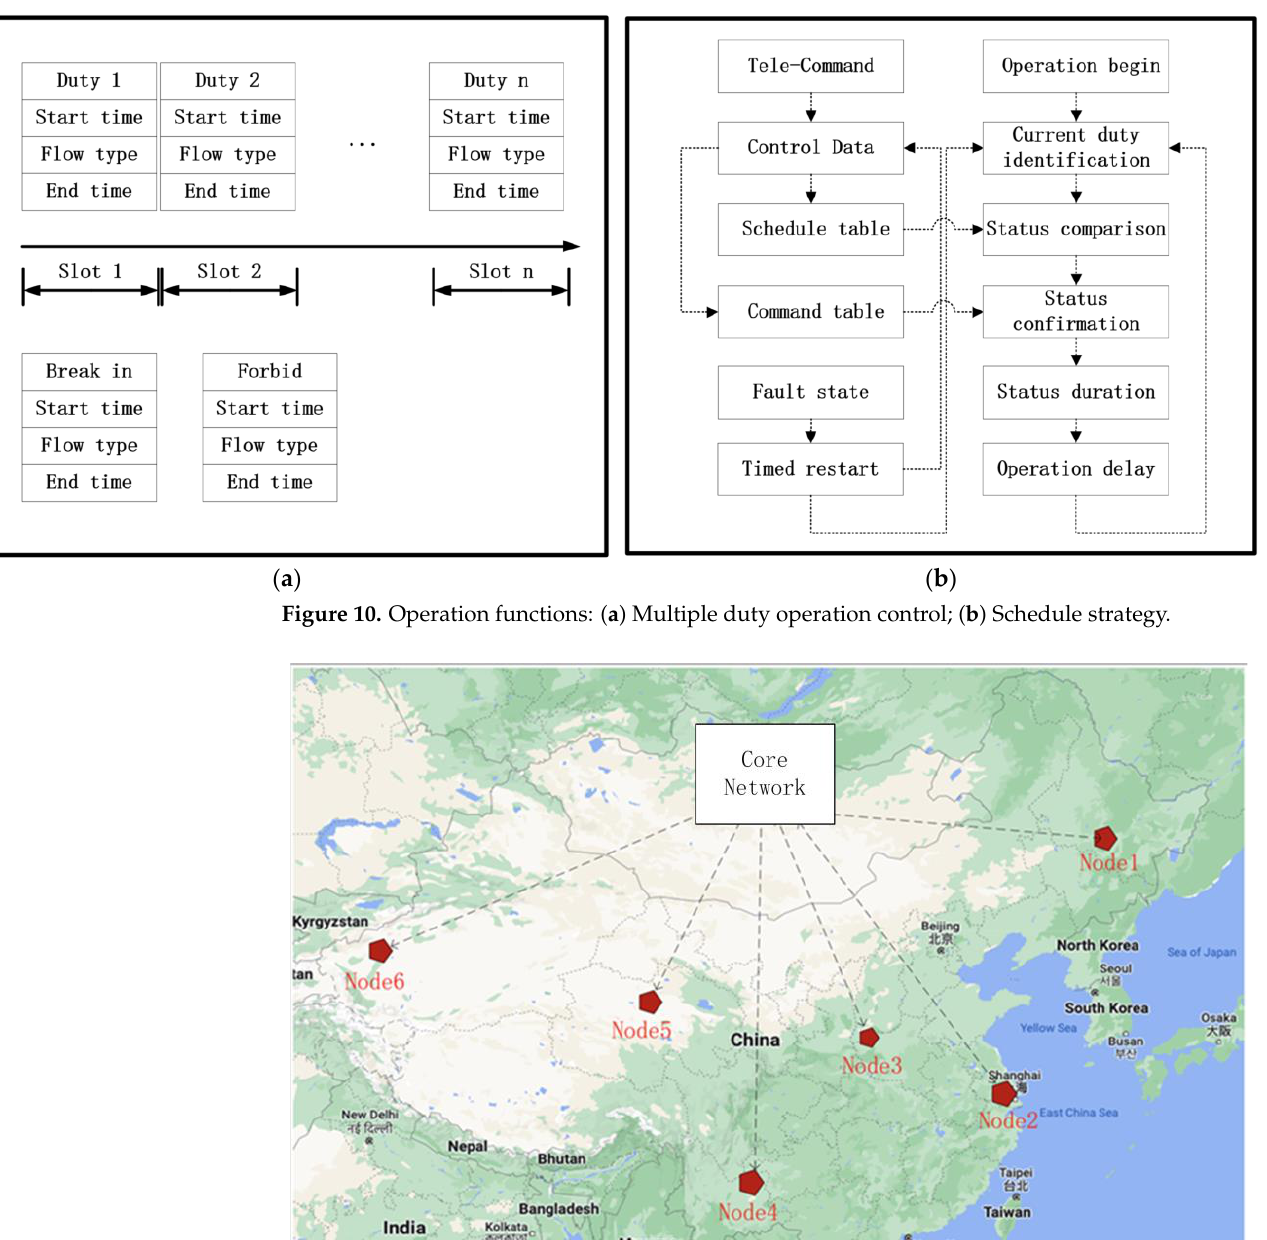
( b ) Figure 12. Ground gateway design: ( a ) flow design; ( b ) equipment design. 7. Simulations and Experiments